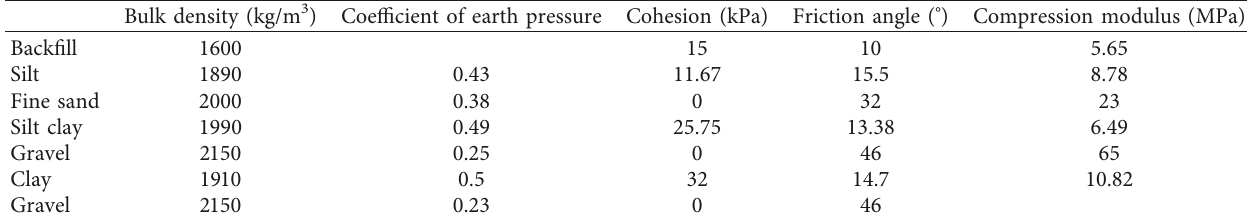
Table 1: Physical and mechanical properties of